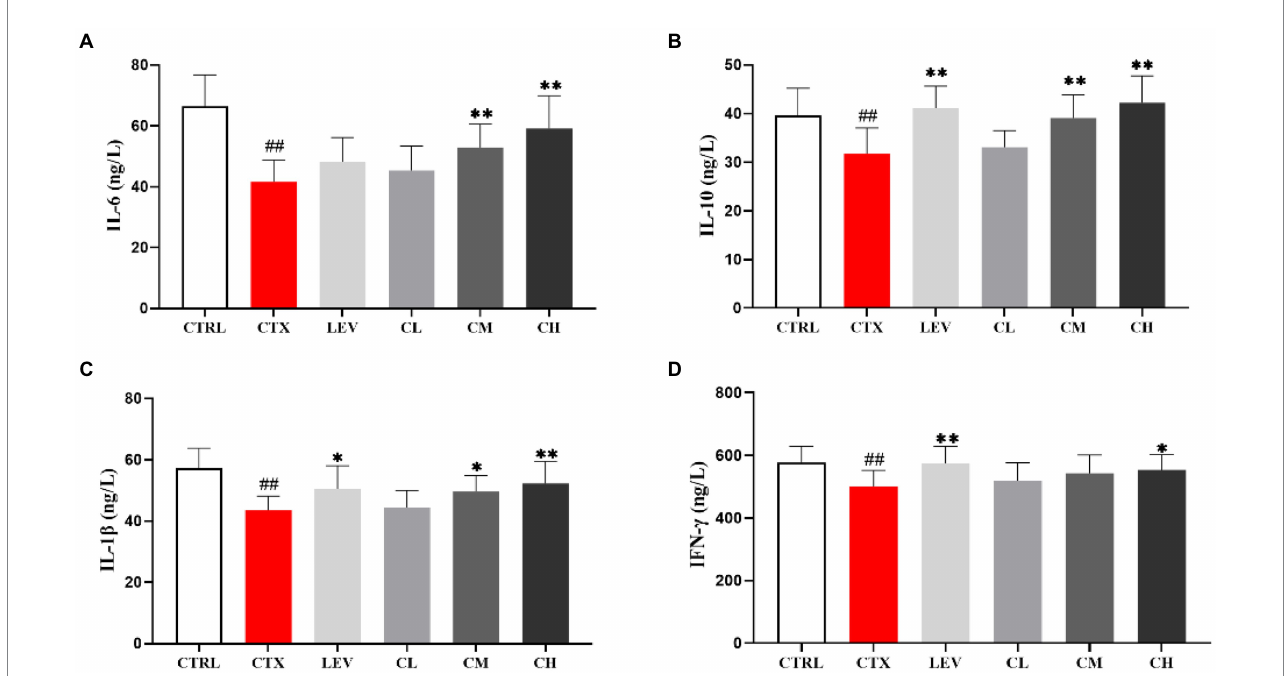
FIGURE 5 Effect of complex probiotics on serum cytokine levels in mice. ( n = 8 for each group). (A) IL-6, (B) IL-10, (C) IL-1 β , and (D) IFN- γ . CTRL, normal control group; CTX, model control group; LEV, levamisole hydrochloride; CL, low-dose complex probiotics; CM, Medium-dose complex probiotics; CH, high-dose complex probiotics. All data are expressed as mean ± SD. # p < 0.05, ## p < 0.01, ### p < 0.001 compared with CTRL; * p < 0.05, ** p < 0.01, *** p < 0.001 compared with